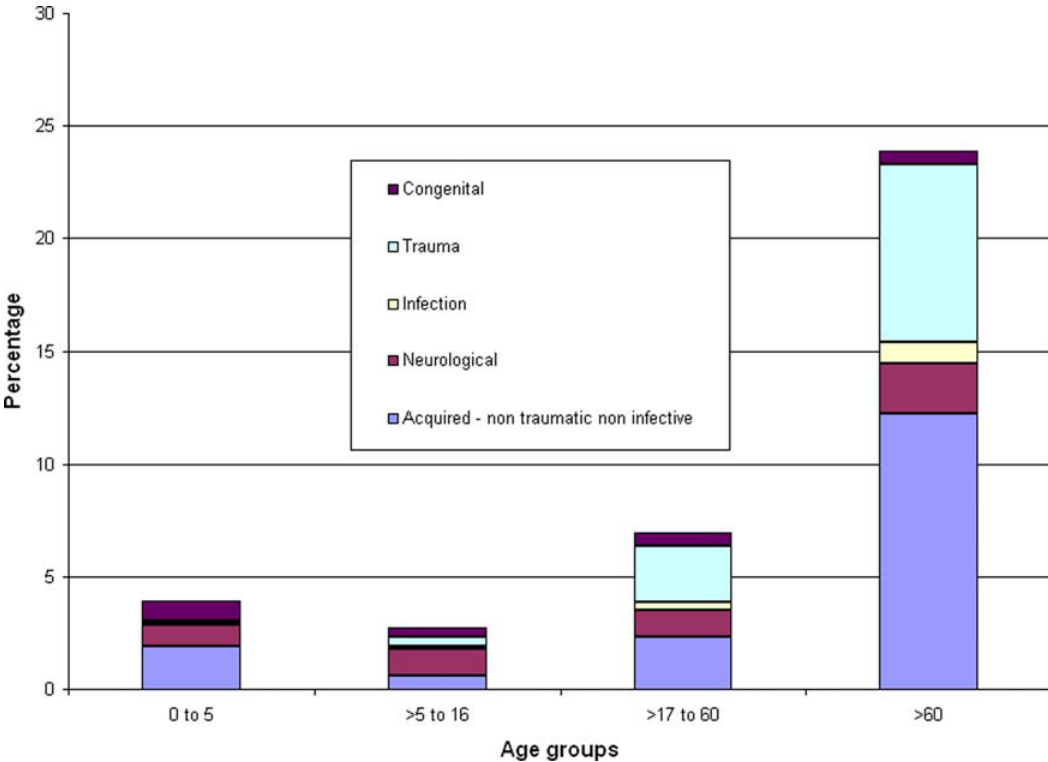
Figure 1. Prevalence and diagnostic categories of MSI, by age group.